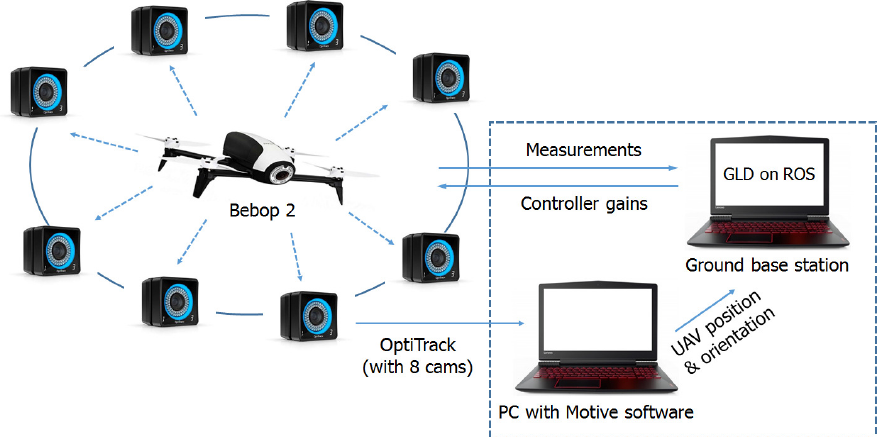
Figure 7. Simplified block diagram of measurement and control signal architecture used during the experiments with in-flight tuning of